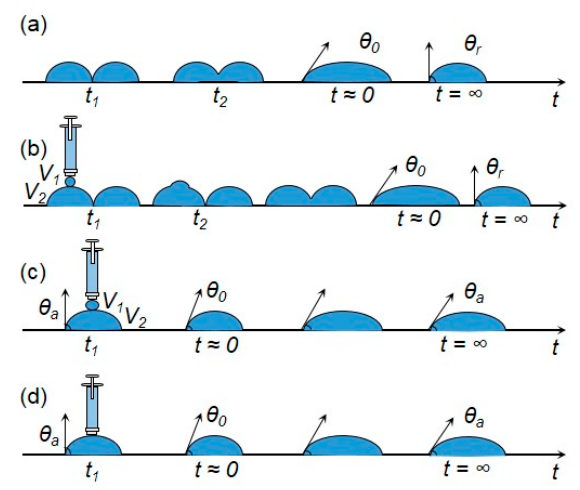
Figure 9. Sketch of ( a ) coalescence process in condensation growth experiment; ( b ) coalescence process in syringe-deposition experiment; and ( c , d ) spreading of droplet in syringe-deposition